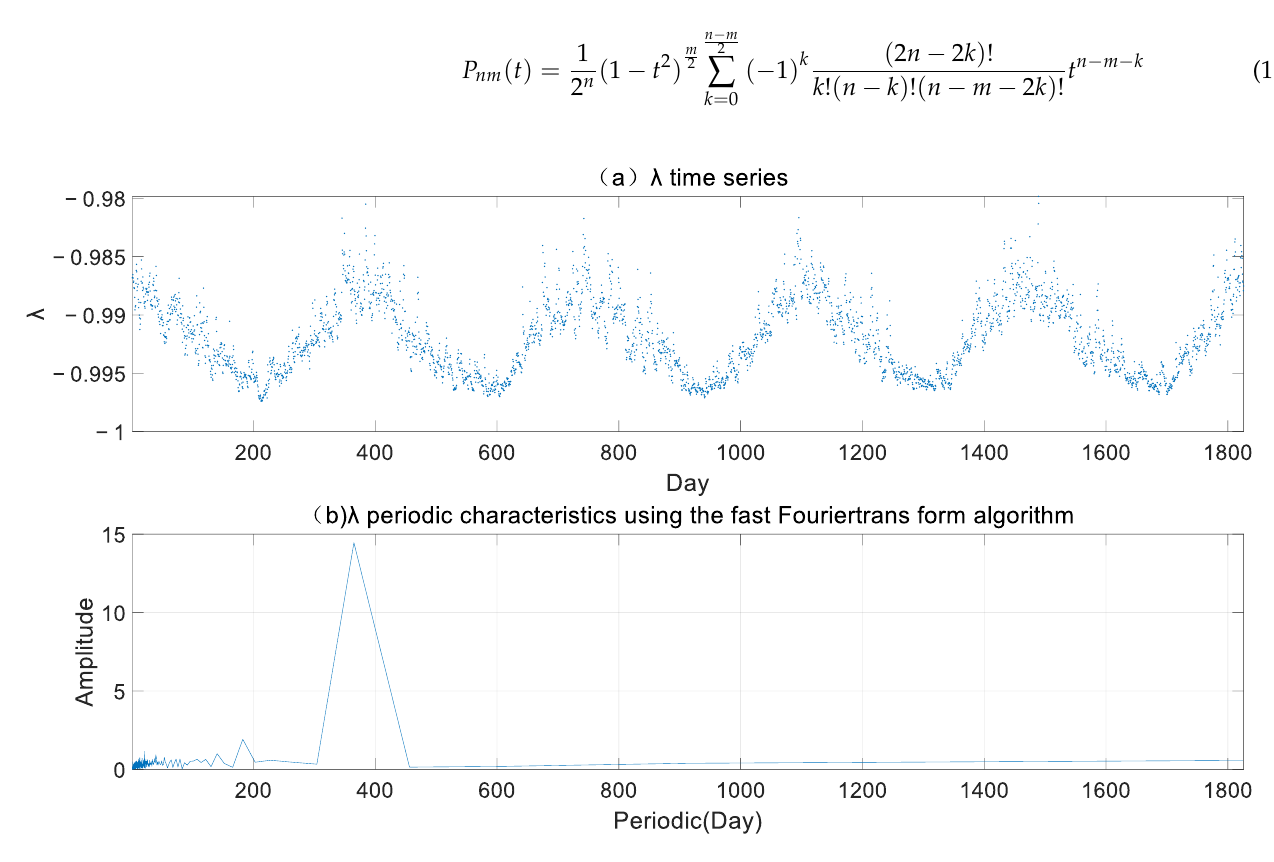
Figure 3. Same as Figure 2 but for the water vapor decrease factor. Vertical correction A PWV difference occurs when the elevation difference between the reanalysis product point and the desired position is large [51]. In this study, we selected the ERA5 atmospheric layered meteorological data from 2015 to 2019 to calculate the PWV of different atmospheric pressure altitude and its corresponding atmospheric pressure according to Equation (1). Then, regression analysis is used to analyze the relationship between PWV and pressure. The results are shown in Figure 4.